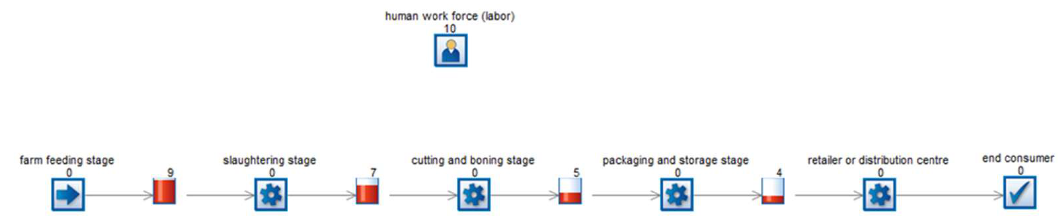
Figure 4. Scenario 1 simulation model of the beef supply chain.